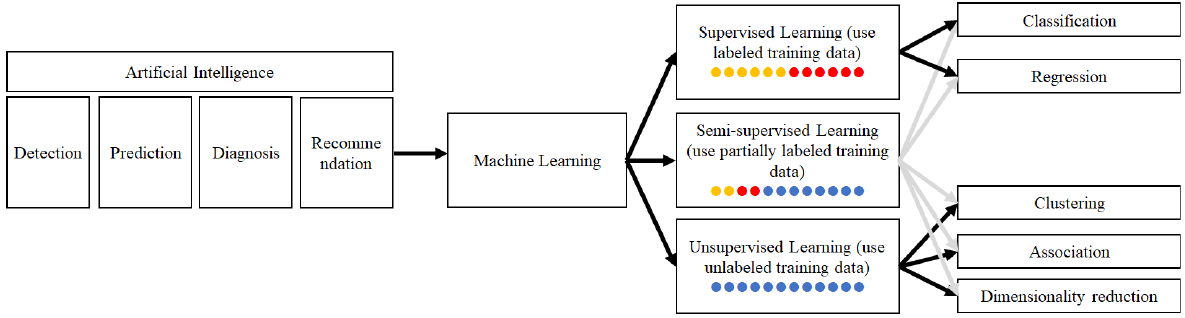
Figure 3. The application of artificial intelligence in a pervasive healthcare Internet of Things system. Orange and red dots denote the annotated training data, whereas the blue dots represent the unlabeled training data.